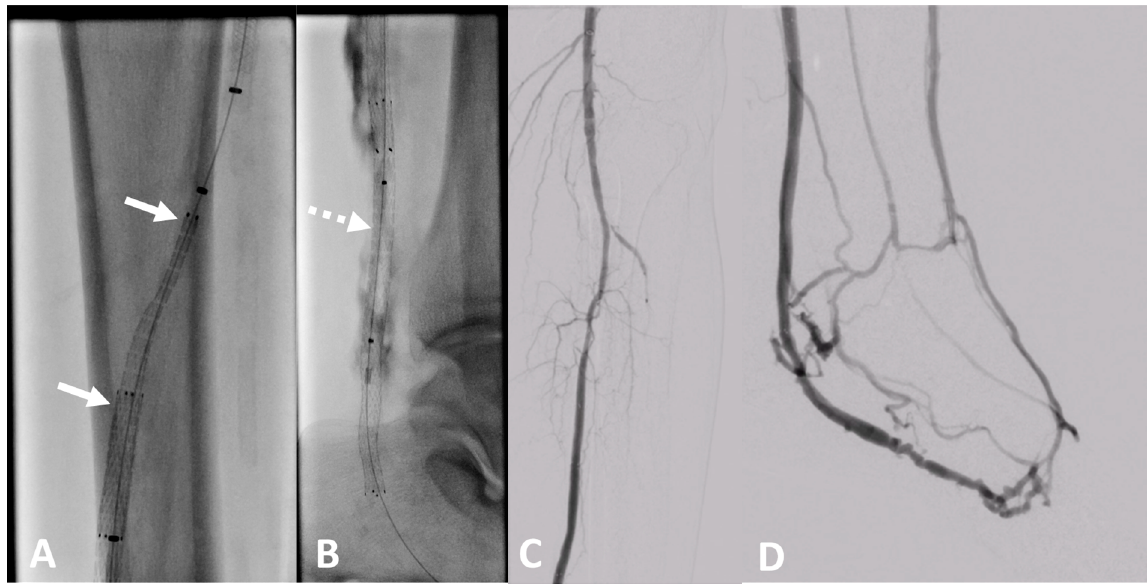
Figure 11. Clinical example of a patient treated at University Hospital Tuebingen with percutaneous deep venous arterialization (pDVA). The aim of this intervention is the redistribution of arterial blood to the foot via the tibial veins as a conduit. ( A ) Implantation of a dedicated tapered LimFlow endograft for crossing from the posterior tibial artery to a tibial vein (white arrows). ( B ) Straight LimFlow endografts in the tibial vein covering side branches until the foot (dotted arrow). ( C ) Angiographic of the proximal lower leg image after implantation of the LimFlow endografts. ( D ) Final angiographic result of the arterialized venous foot arch after successful